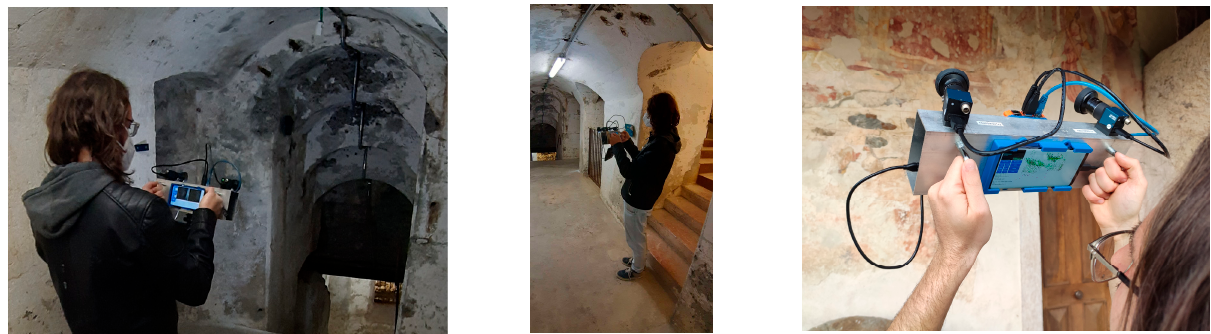
Figure 1. The proposed handheld, low-cost, low-power prototype (named GuPho) based on stereo cameras and V-SLAM method for 3D mapping purposes. It includes a real-time guidance system aimed at enabling optimized and less error prone image acquisitions. It uses industrial global shutter video cameras, a Raspberry Pi 4 and a power bank for an overall weight less than 1.5 kg. When needed, a LED panel can also be mounted in order to illuminate dark environments as shown in the two images on the left.